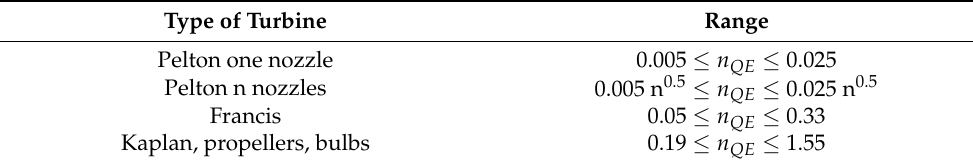
Table 2. Ranges of the specific speed of each type of turbine [41].